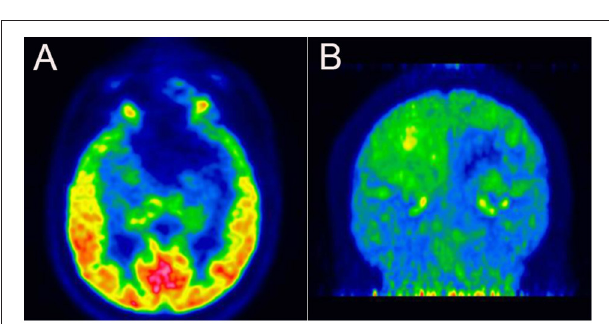
FIGURE 3 | (A,B) 18 F-fluorodeoxyglucose positron-emission tomography revealing low glucose metabolism in the left frontal-temporal